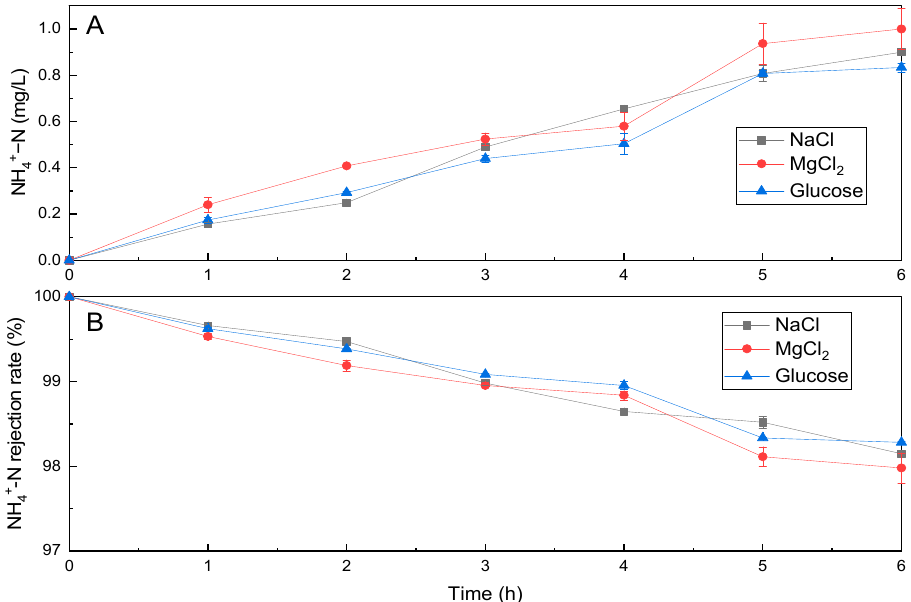
Figure 7. Effects of NaCl, MgCl 2 and glucose DSs in the MD process at a permeate temperature of 20 °C and a DS temperature of 50 °C with 1L of permeate and DS, respectively, at the beginning of MD, on ( A ) the NH 4+ -N concentration on the permeate side and ( B ) the NH 4+ -N rejection rate.